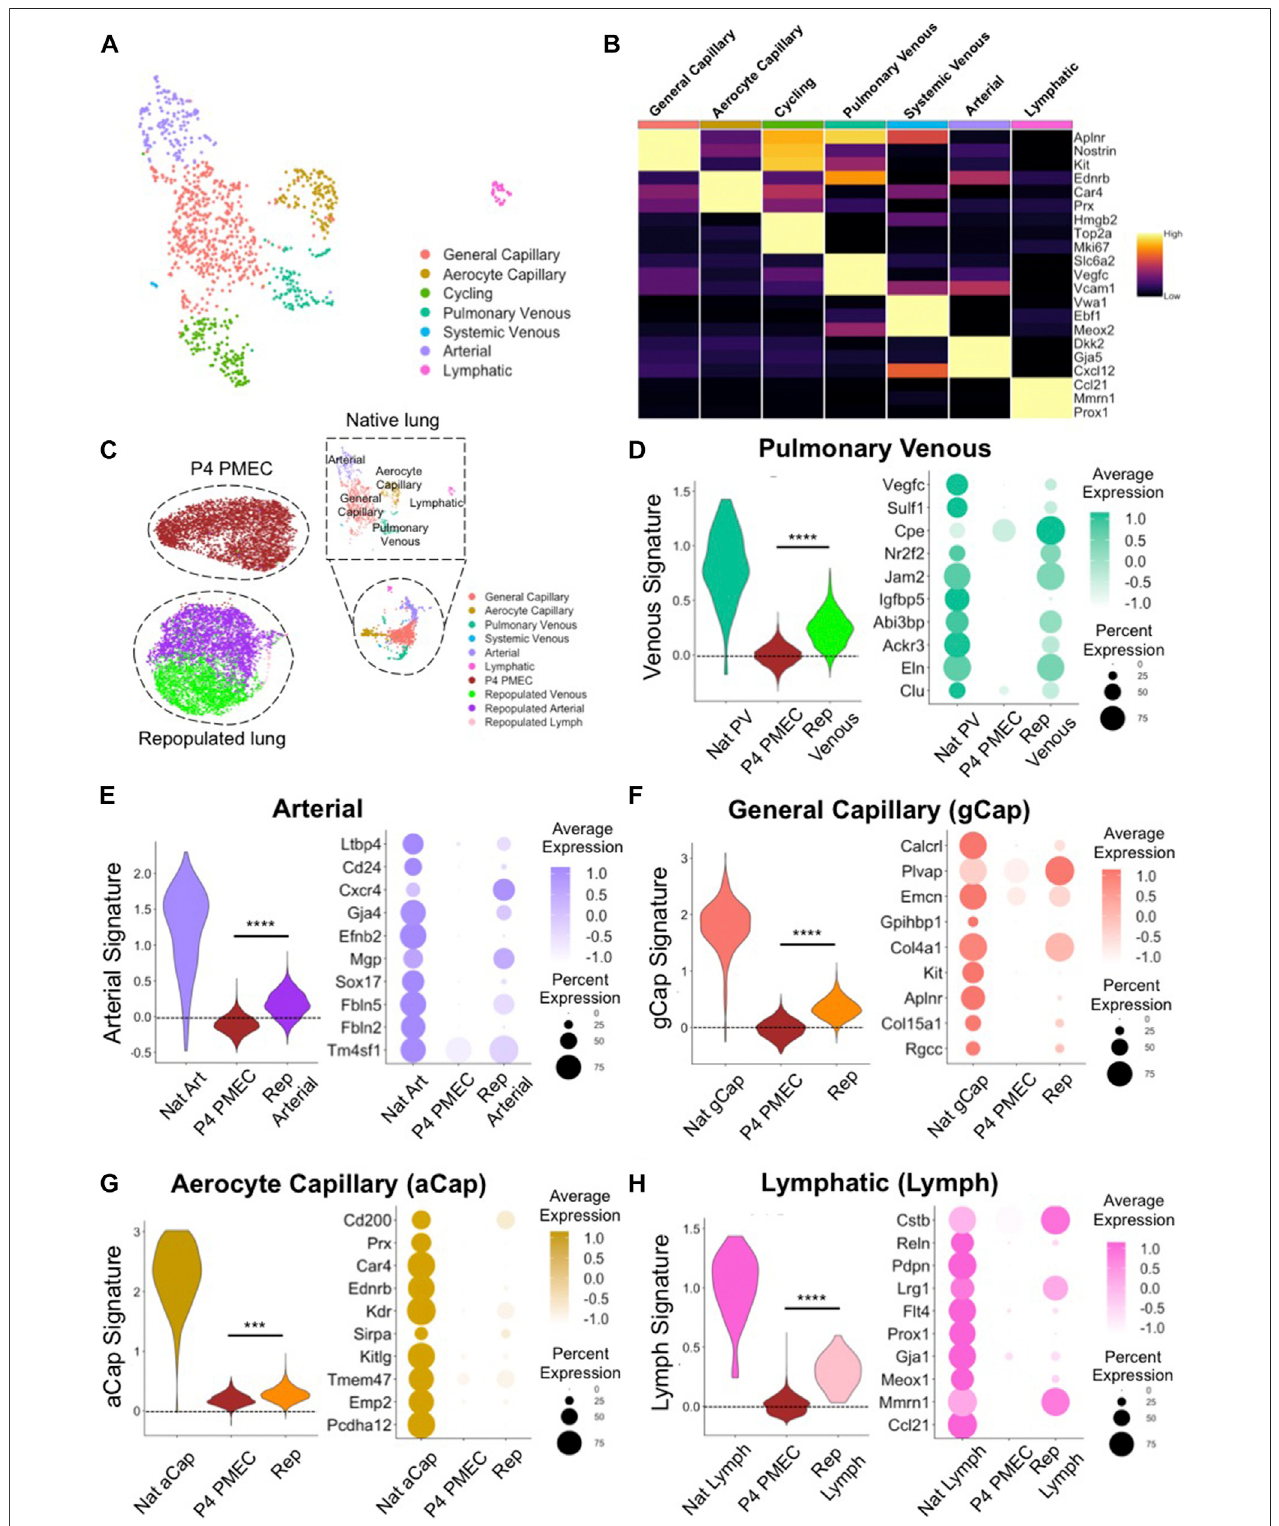
FIGURE 4 | scRNAseq evaluation of native and engineered rat pulmonary endothelium. (A) Uniform Manifold Approximation and Projection (UMAP) of the native pulmonary endothelial clusters. (B) Heatmap of top 3 DEGs for each cluster. (C) UMAPplots of merged object of native pulmonary endothelial clusters, pre-seeded